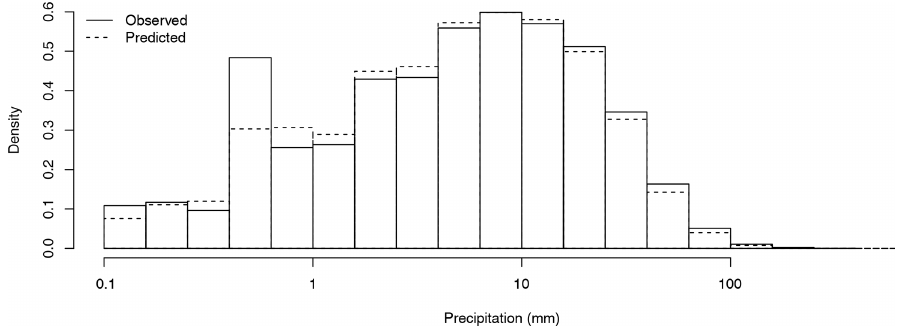
Figure 5. Histograms of observed and predicted daily precipitation